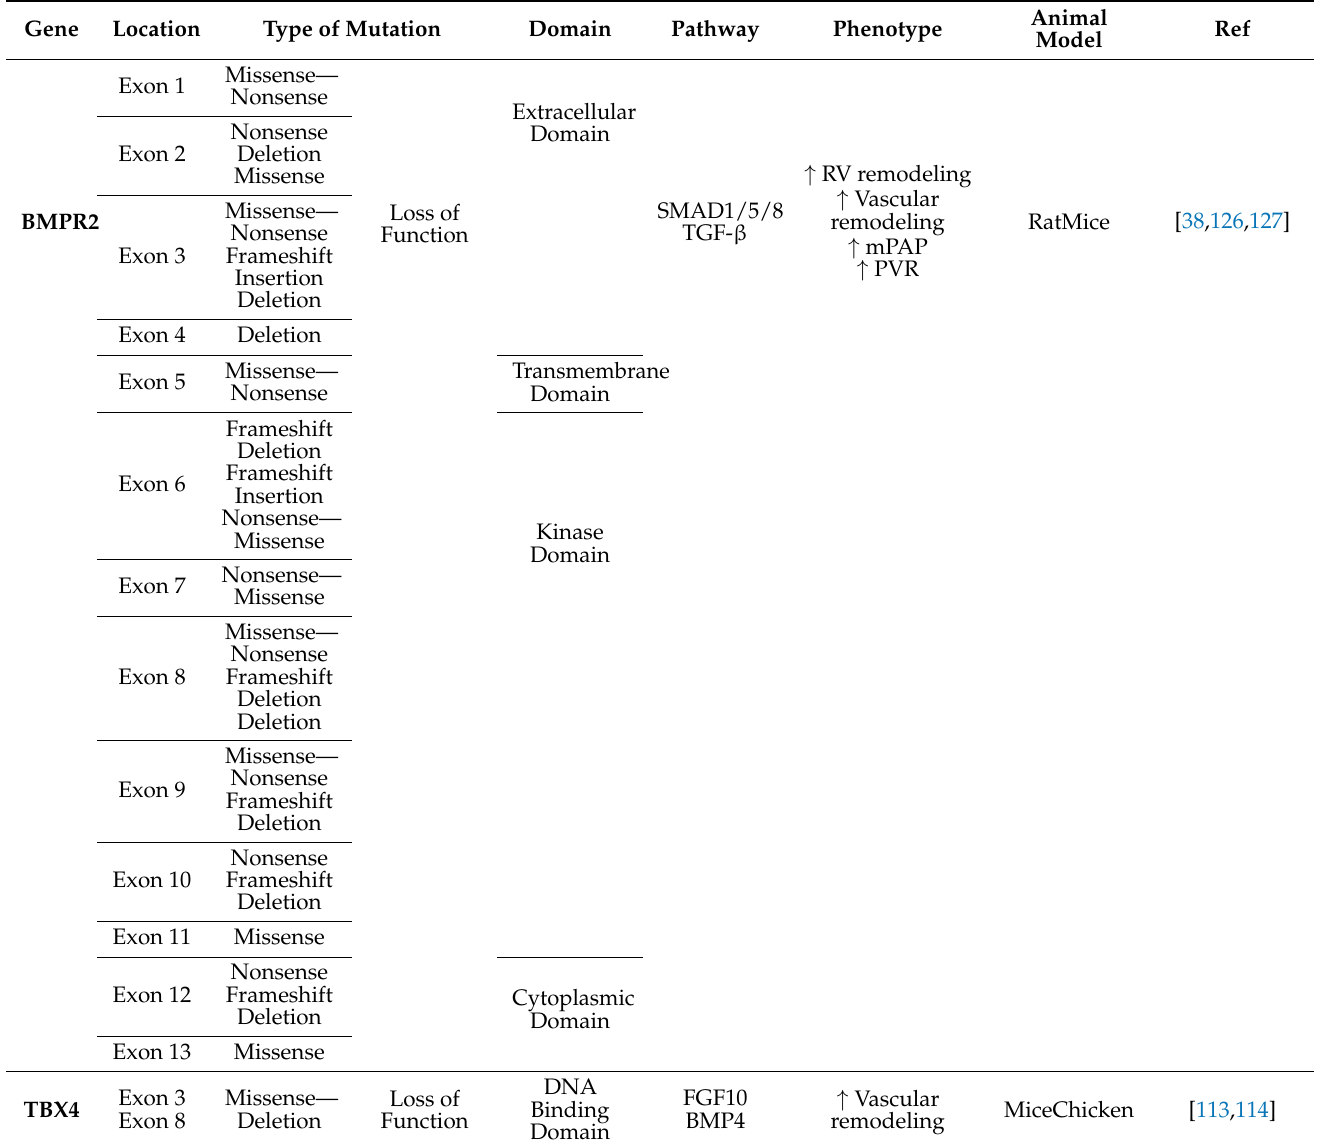
Table 1. This table entails the genetic variants in PAH, the respective affected location, domain, pathway, and phenotype. Gene Location Type of Mutation Domain Pathway Phenotype